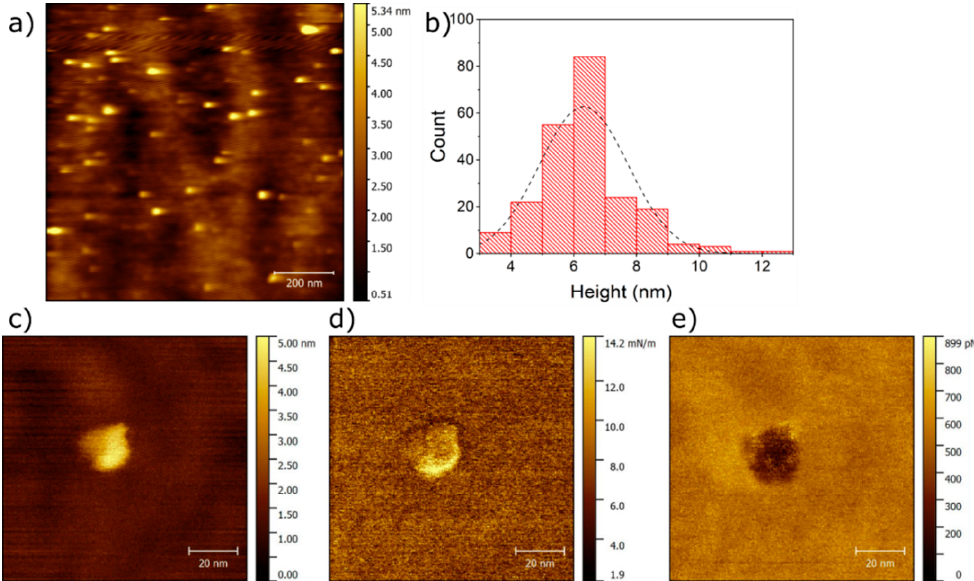
Figure 3. AFM image of Ag clusters deposit on a SiO 2 wafer substrate. ( a ) Topographical height obtained in contact mode; ( b ) Histogram of Ag NPs from contact-mode images; ( c ) Height in QI TM mode; ( d ) Elastic constant in QI mode; ( e ) Adhesion in QI